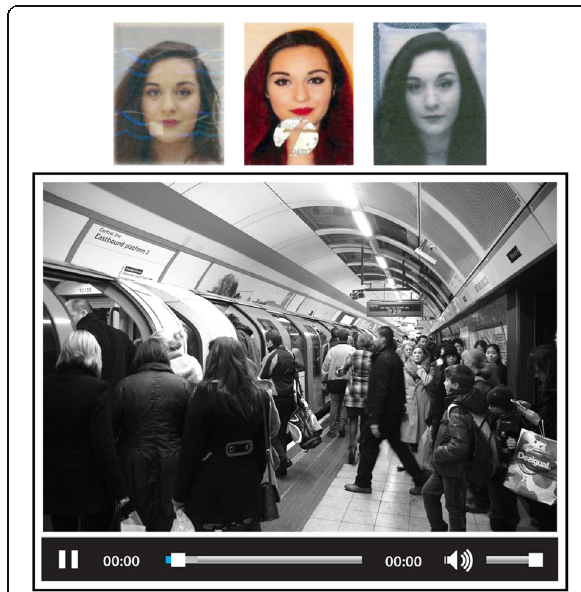
Fig. 1 Representation of a face-search trial. Images at the top are from different ID cards of the target person. Legal restrictions prevent publication of the original target and closed-circuit television (CCTV) images. The target person shown here is a volunteer who has given permission for the images to be reproduced and the CCTV-still is a reproducible image very similar to those used in the experiment (see image